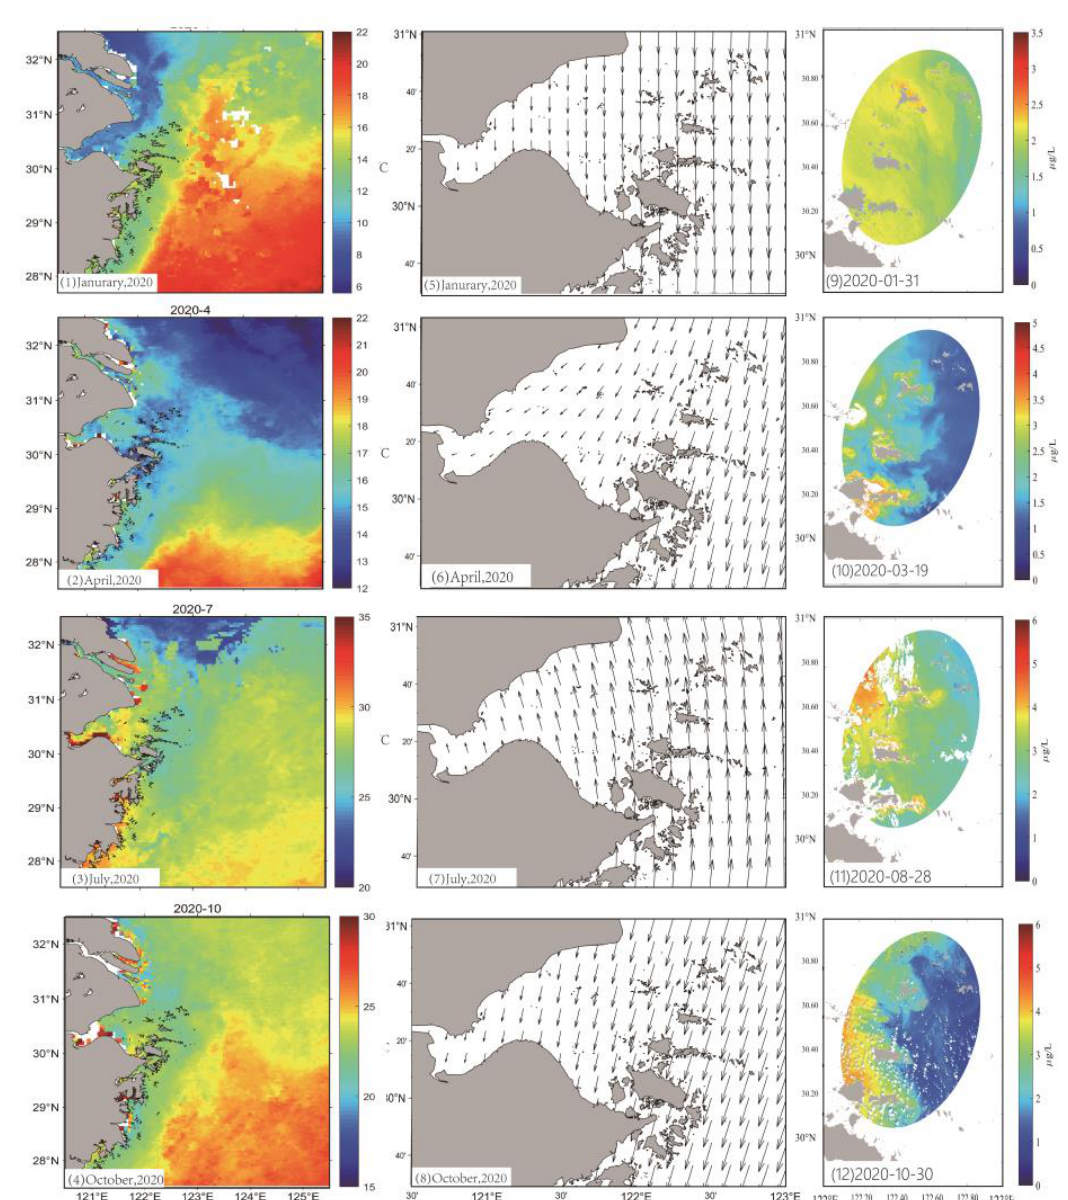
Figure 8. ( 1 – 4 ) Average SST of winter, spring, summer, autumn. ( 5 – 8 ) Wind of the corresponding month in Hangzhou Bay. ( 9 – 12 ): The Chl-a concentration in the representative days of four seasons in island intensive area.